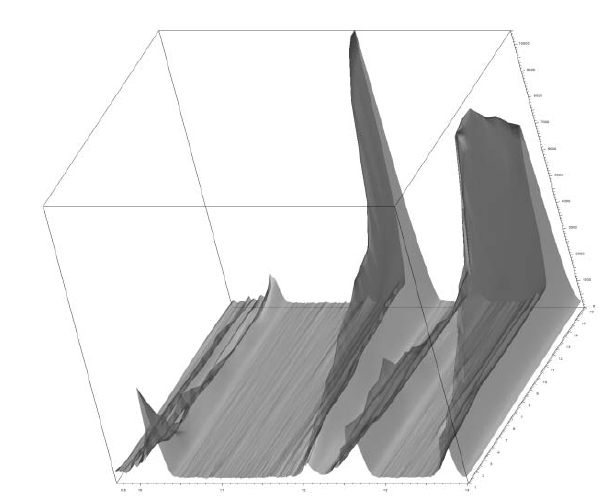
Figure 10. Time-resolved PXRD patterns of orthorhombic paracetamol (form II) at 90% relative humidity, recorded sequentially every 60 min (first pattern in the